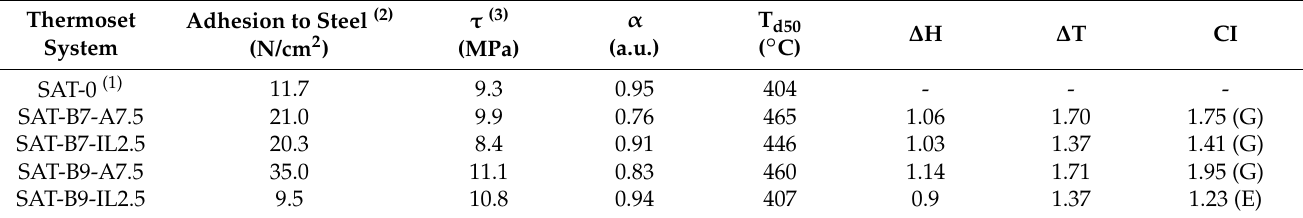
Table 6. Comparison of adhesive, mechanical, and thermal properties, as well as CI values, of selected thermosetting systems based on the